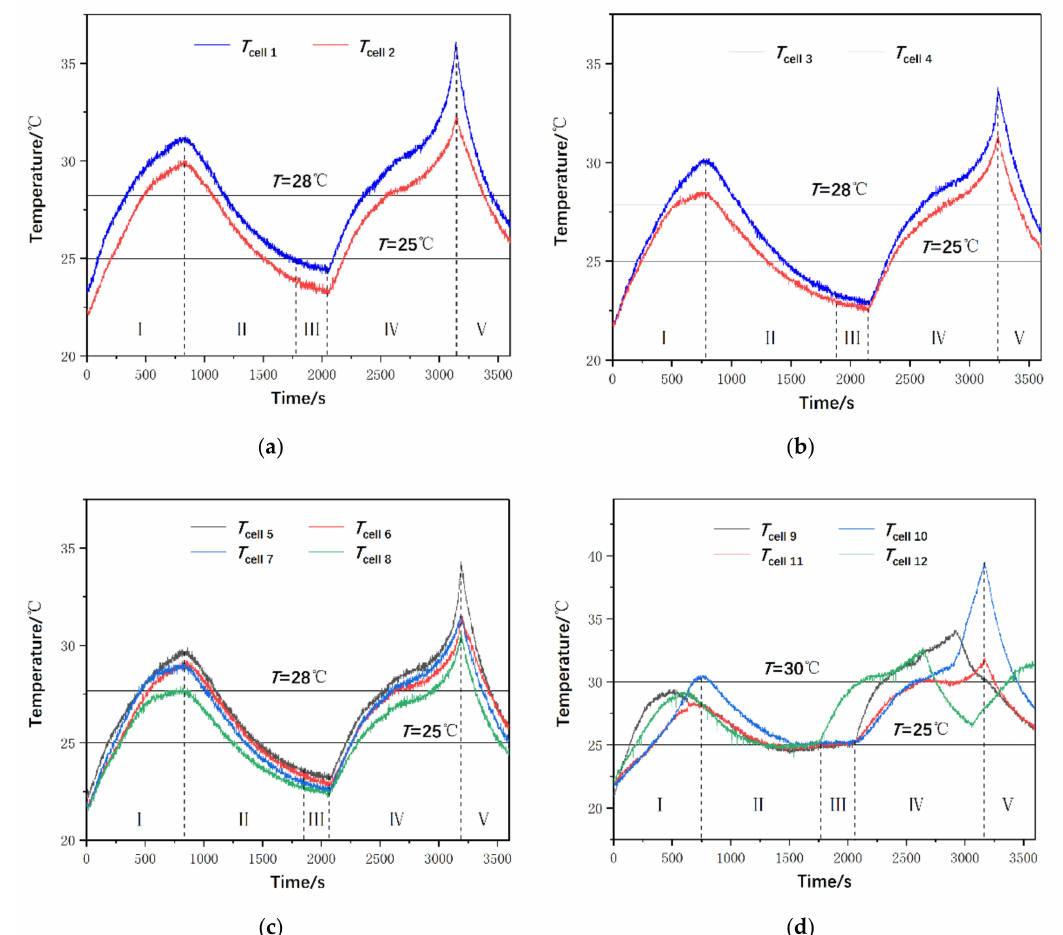
Figure 5. Surface temperatures of all the cells in the charge–discharge profiles: ( a ) Pack A; ( b ) Pack B; ( c ) Pack C; ( d ) Pack D.